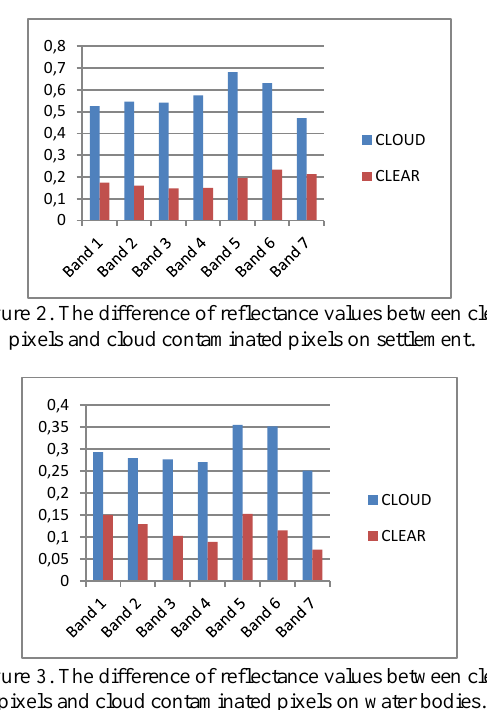
Figure 1. The difference of reflectance values between clear pixels and cloud contaminated pixels on vegetation.